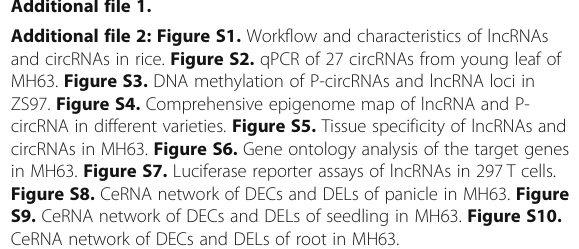
Additional file 2: Figure S1. Workflow and characteristics of lncRNAs and circRNAs in rice. Figure S2. qPCR of 27 circRNAs from young leaf of MH63. Figure S3. DNA methylation of P-circRNAs and lncRNA loci in ZS97. Figure S4. Comprehensive epigenome map of lncRNA and P- circRNA in different varieties. Figure S5. Tissue specificity of lncRNAs and circRNAs in MH63. Figure S6. Gene ontology analysis of the target genes in MH63. Figure S7. Luciferase reporter assays of lncRNAs in 297 T cells. Figure S8. CeRNA network of DECs and DELs of panicle in MH63. Figure S9. CeRNA network of DECs and DELs of seedling in MH63. Figure S10. CeRNA network of DECs and DELs of root in MH63.